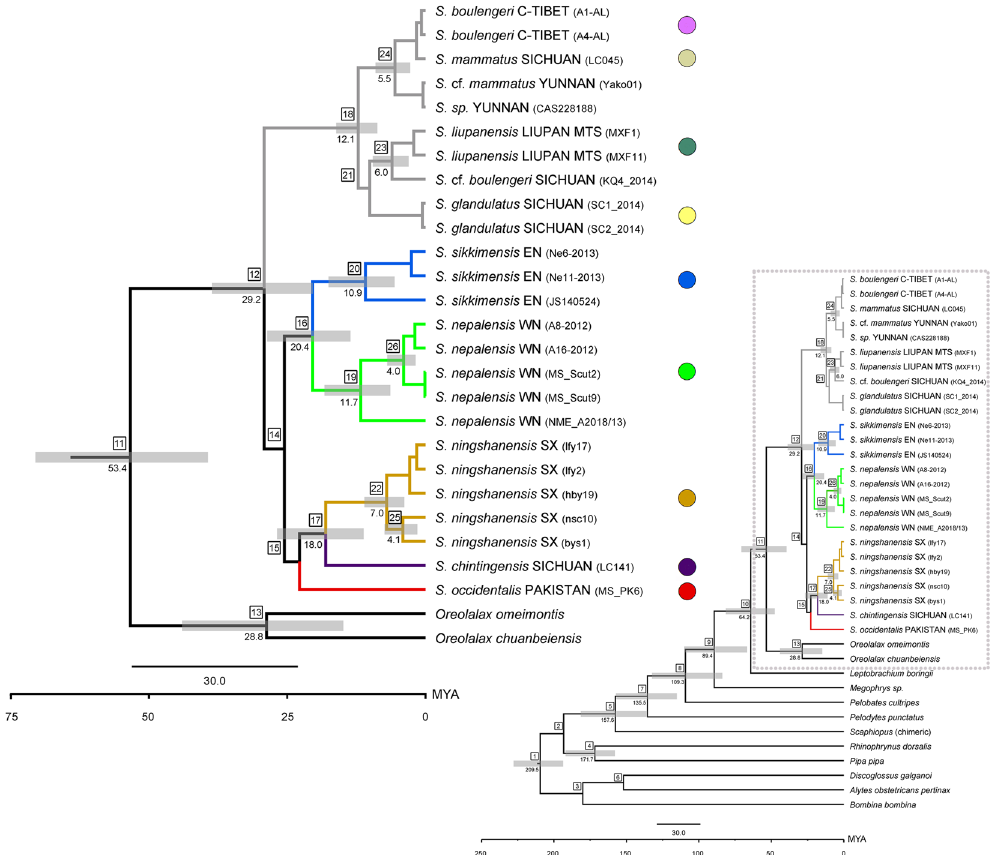
Figure 3. Time-calibrated phylogeny based on the combined 16 s + co1 + cytb + nd4 mtDNA data analysis. The divergence times (in Mya) were estimated using fossil calibration points. Dates are only shown for well supported nodes (posterior probability values ≥ 0.95) and for nodes ≥ 4 Mya. Node numbers correspond to Supplementary Table S3 that specifies the individual values and 95% highest posterior density intervals